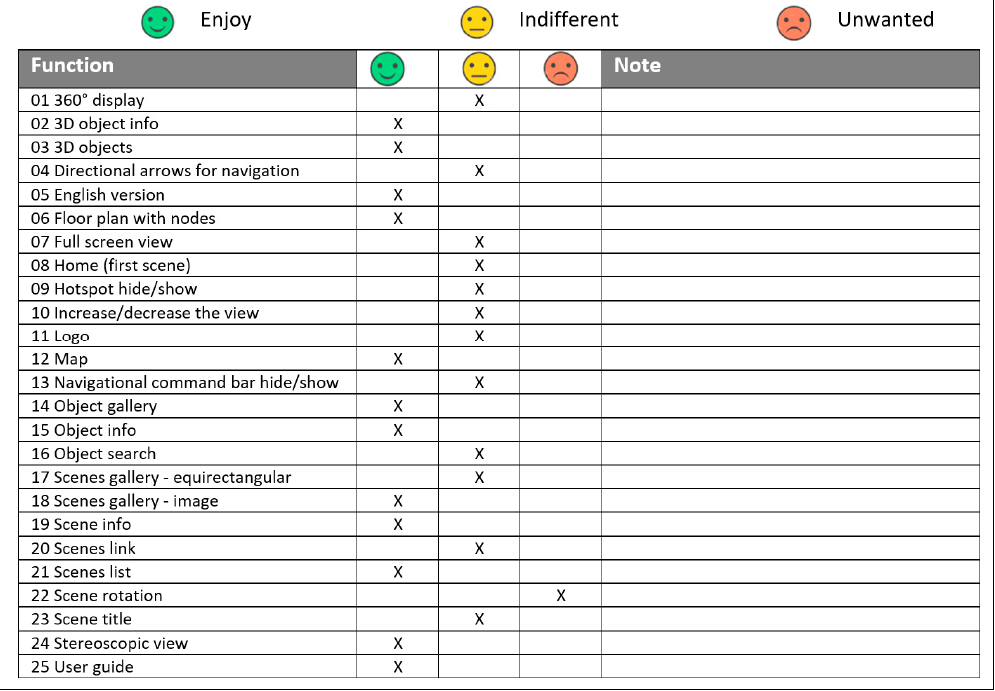
Figure 9. Questionnaire for virtual tour functions.